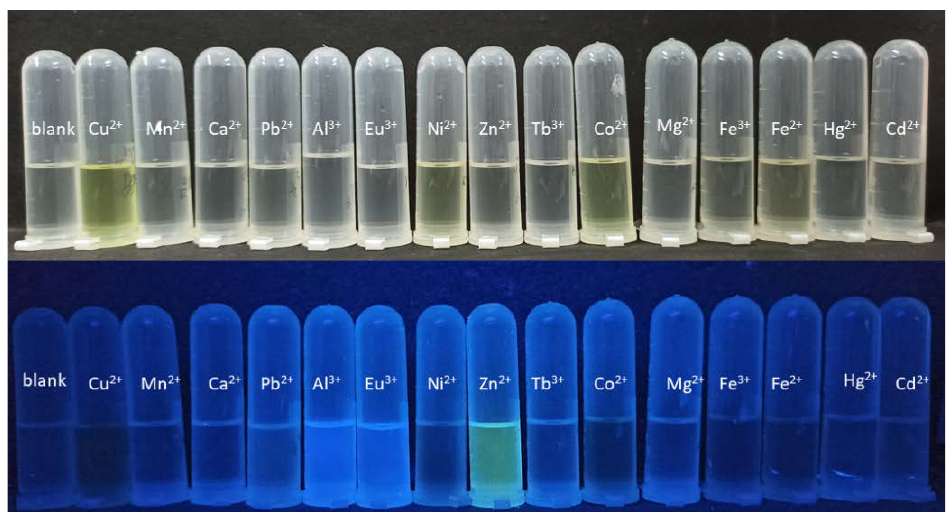
Figure 9. The images of solution 1 in dioxane with 10 eq. different metal ions. The upper and lower were obtained at daylight and under 365 nm.